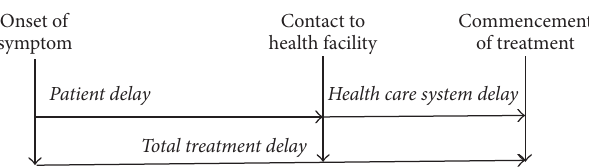
Figure 1: Components of different delay periods from the onset of symptom to the commencement of treatment. Modified from WHO diagnosis and treatment delay study